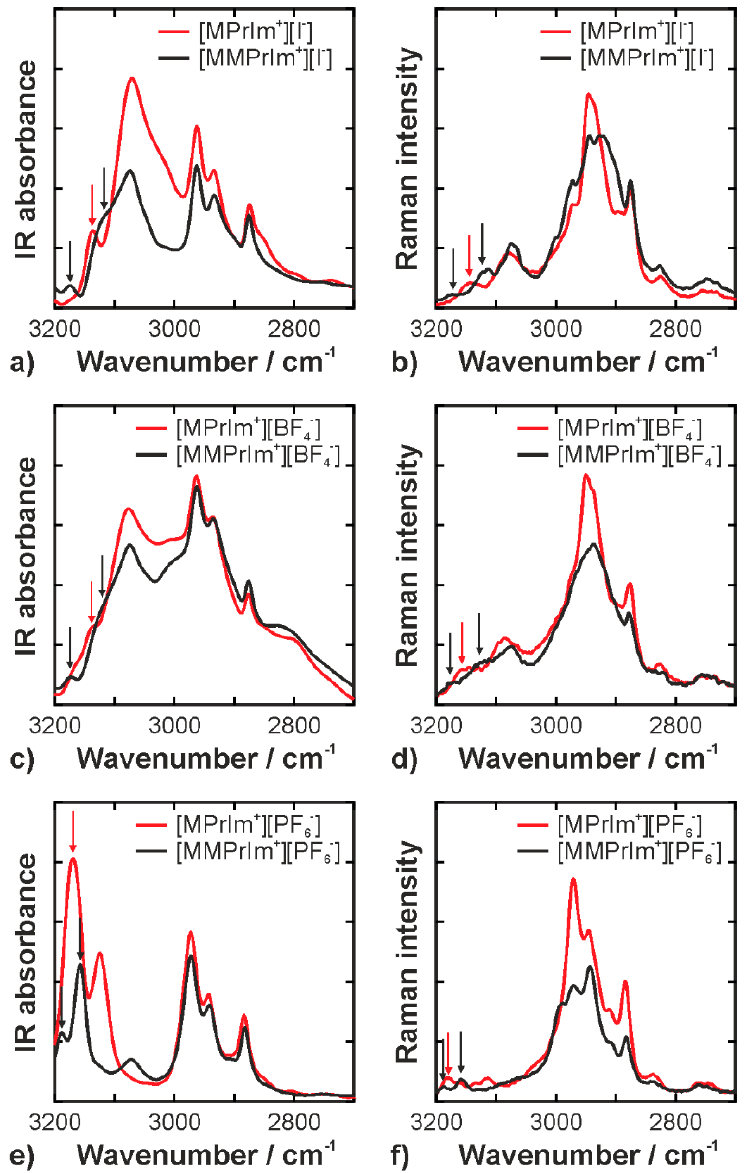
Figure 4. Infrared ( a , c , e ) and Raman ( b , d , f ) spectra in the CH stretching region. The relevant peaks and shoulder bands are marked by arrows; ( a ) and ( b ) show the data of the iodide ILs; ( c ) and ( d ) show the data of the tetrafluoroborate ILs; ( e ) and ( f ) show the data of the hexafluorophosphate ILs.